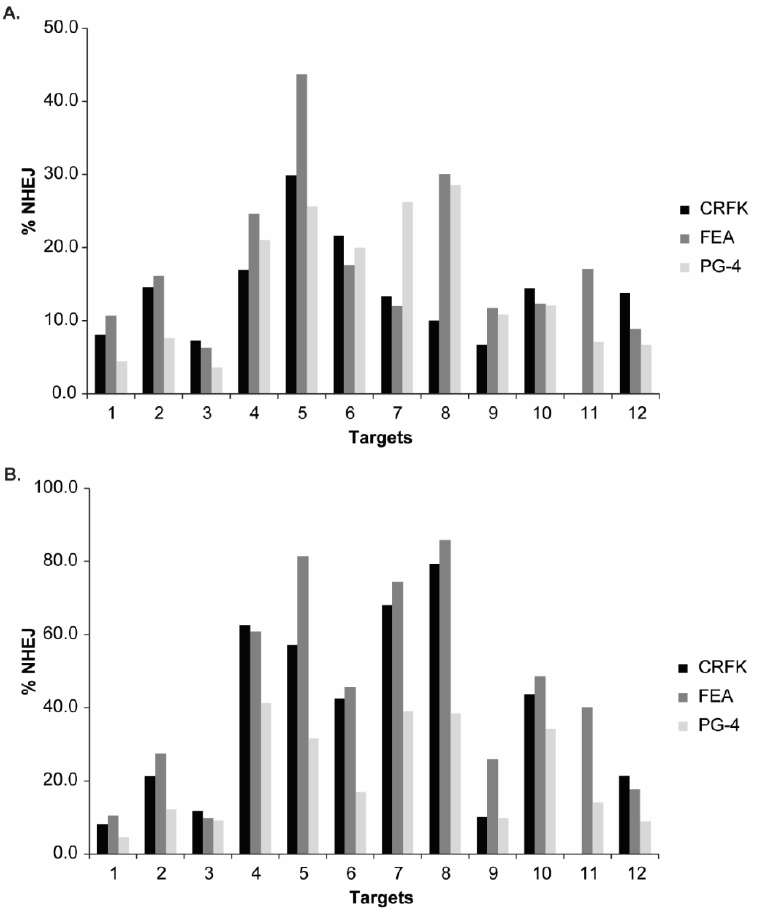
Figure 6. NHEJ frequency in CRFK, FEA, and PG-4 cells using CRISPR/ Sa Cas9 editing for 12 FeLV targets and analyzed with the T7E1 and TIDE assay. After CRISPR/ Sa Cas9 transfection and cell sorting, all 12 target regions within FeLV were amplified and analyzed using either the T7E1 assay measured by FA ( A ) or TIDE ( B ). Cleavage frequency, as determined by FA, was calculated into % NHEJ. Three cell lines (CRFK, FEA, and PG-4) are shown for each target and plotted against their % NHEJ (y-axes; % NHEJ = 100 × (1 − √1 − (𝑎+𝑏) ), with a and b being the cleaved DNA and c being (𝑎+𝑏+𝑐) the uncut DNA [51] ). For target 11, there were not enough CRFK cells for cell sorting available.